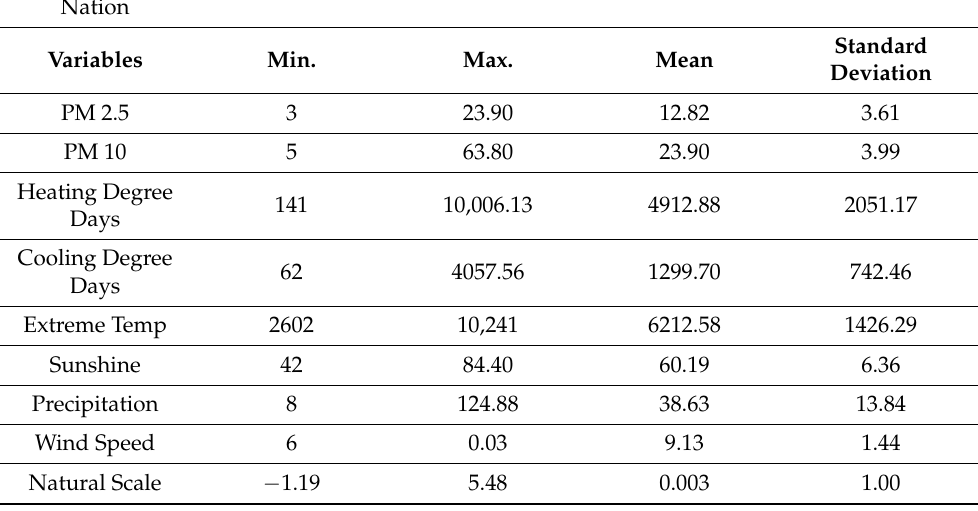
Table A3. Descriptive statistics for climate, geography, and environmental